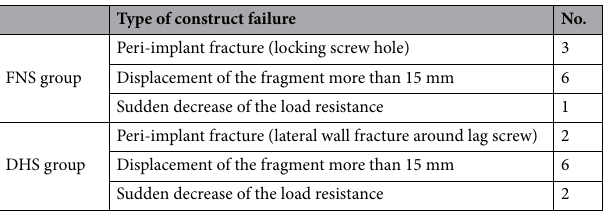
Table 1. Types of construct